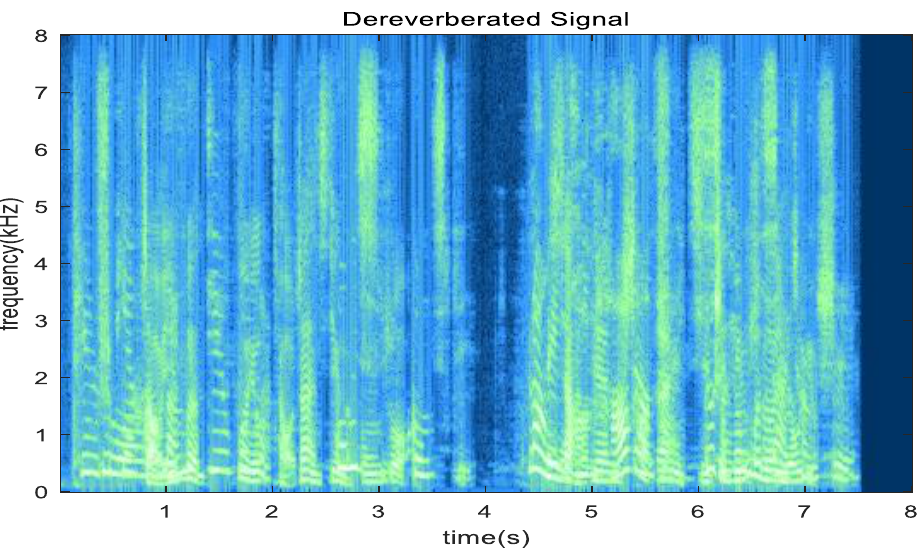
Figure 4. The TF spectrum of the dereverberated signal.